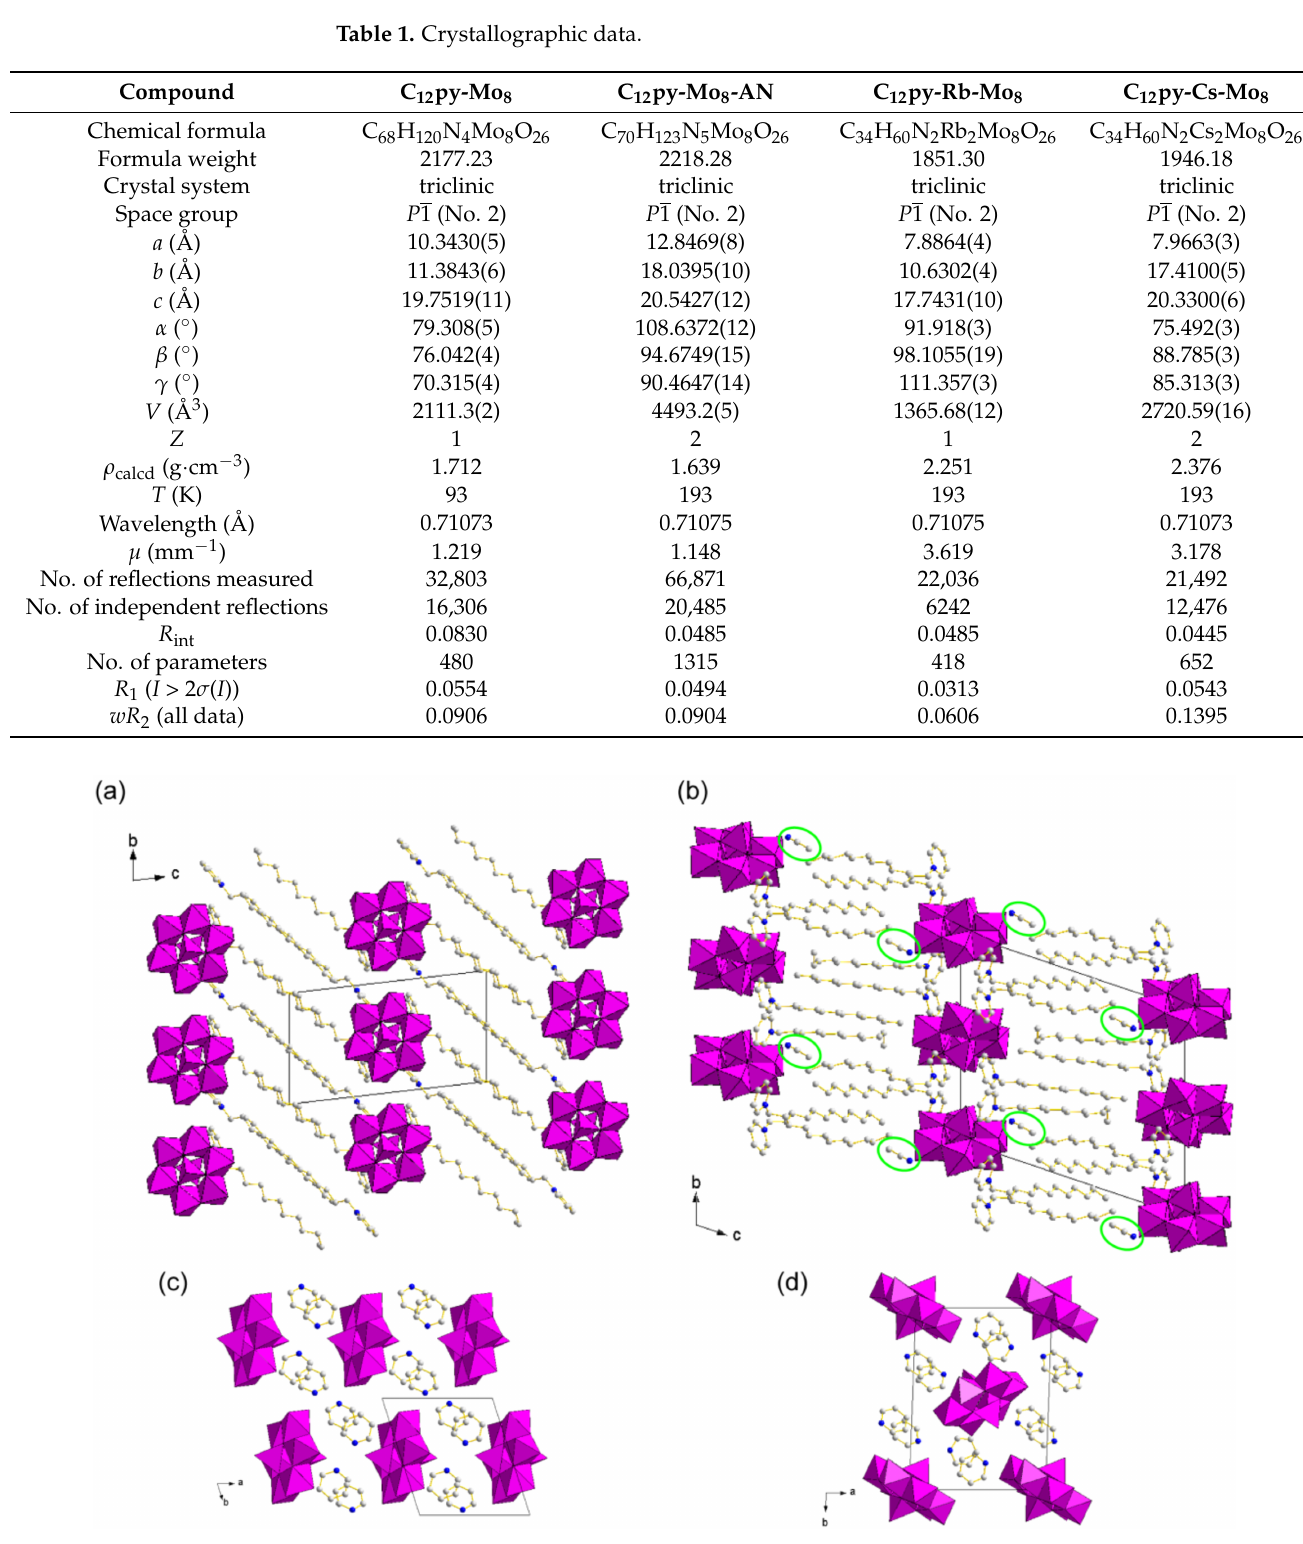
Figure 3. Crystal structures of C 12 py-Mo 8 and C 12 py-Mo 8 -AN (C: gray, N: blue; α -Mo 8 in purple polyhedrons). H atoms and disordered atoms are omitted for clarity: ( a ) Packing diagram of C 12 py- Mo 8 along the a axis; ( b ) Packing diagram of C 12 py-Mo 8 -AN along the a axis. Some solvent molecules are highlighted by green ovals; ( c ) Molecular arrangements of C 12 py-Mo 8 in the inorganic layers ( ab plane); ( d ) Molecular arrangements of C 12 py-Mo 8 -AN in the inorganic layers ( ab